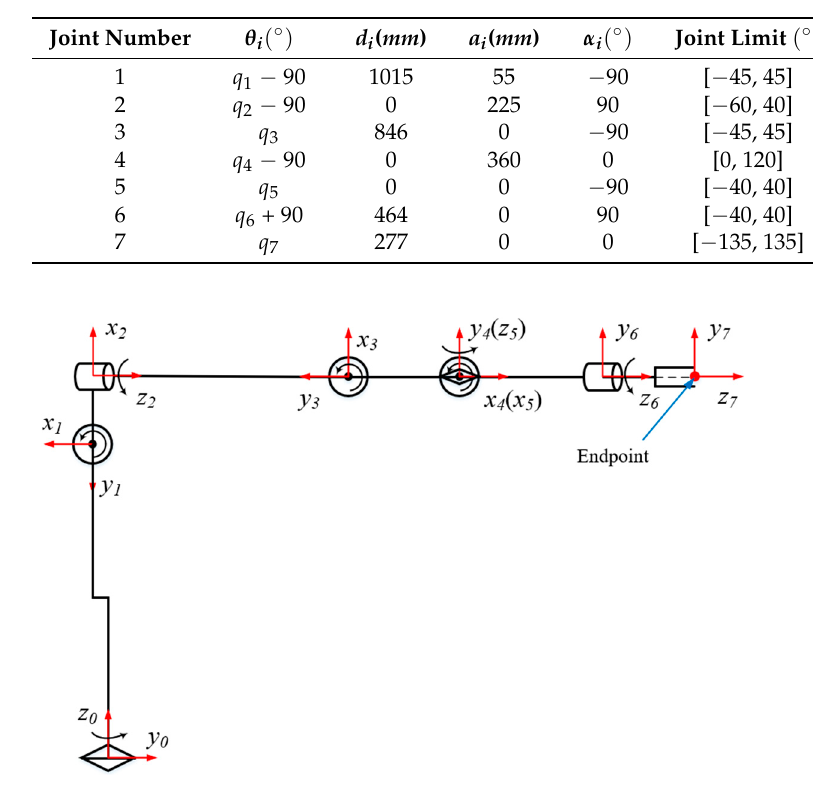
Figure 2. The D–H coordinate system of the